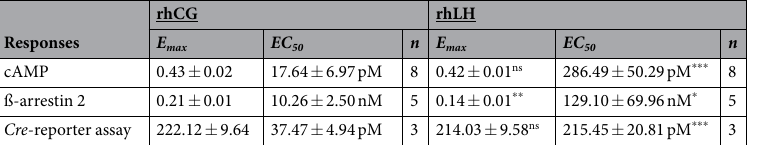
(mLTC-1) 45 either transfected with CAMYEL sensor (Fig. 1C) or not (Fig. 1D), as previously reported 10, 11 . Again, BRET measurements revealed rhCG dose-response curve shifted towards the lower doses compared to rhLH (Fig. 1C). Specifically, the EC 50 value of rhCG was approximately 6 times lower than that of rhLH ( p = 0.0067; n = 5 ) (Table 2). To further confirm these data and to exclude any artifact due to the transfection of CAMYEL sensor in mLTC-1 cells, we also measured cAMP levels in native cells using HTRF-based assay, which does not require any cell transfection. We found a similar pattern of rhCG- and rhLH-induced cAMP responses (Fig. 1D).